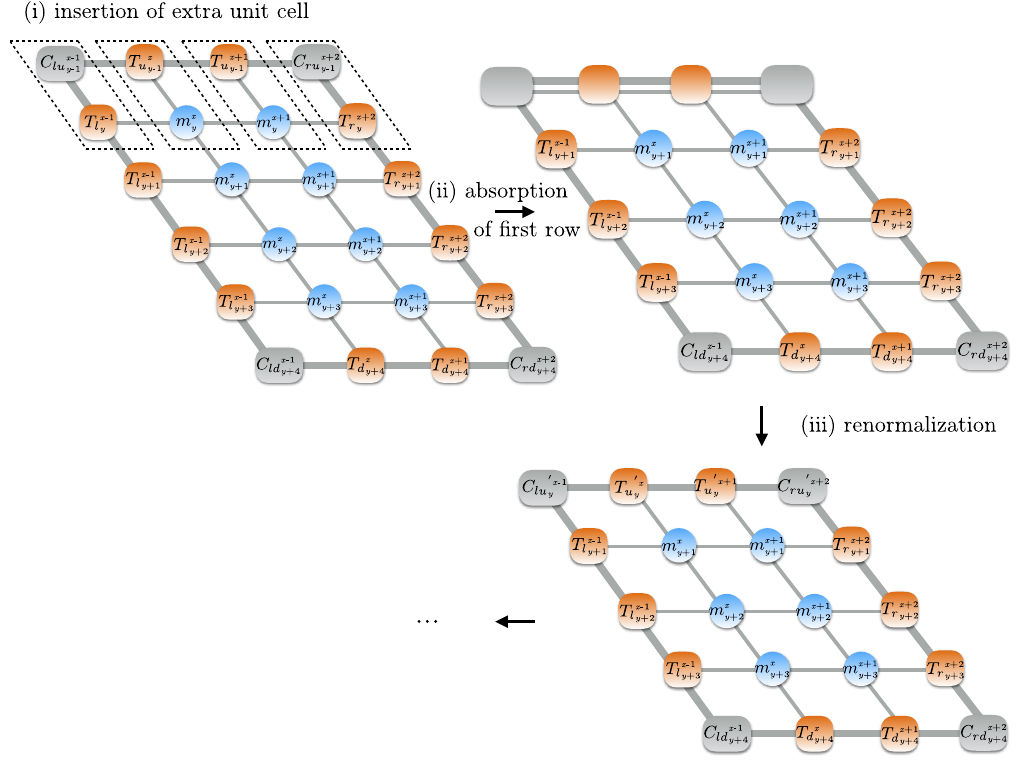
Figure 2: CTM coarse graining move to the top of the lattice: (i) extra unit cell is first inserted, and then row-wise integrated into the upper part of the environment by performing two subsequent (ii) absorption and (iii) renormalization steps (only first step is